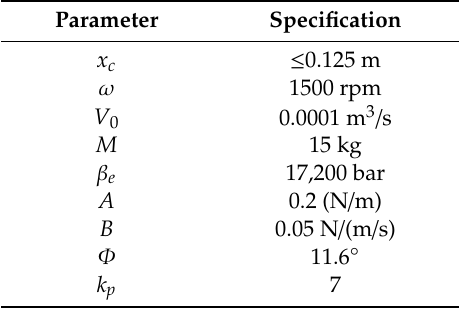
Table 1. Hydraulic Parameters for the electro-hydraulic actuator (EHA)